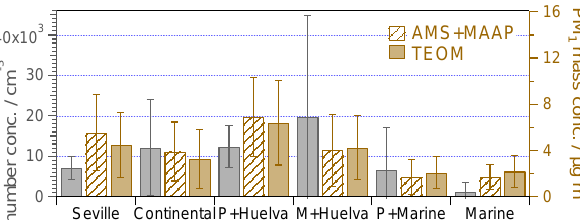
Fig. 6. Averaged particle number (grey) and mass (brown) concen- trations for the individual air mass categories. While hatched brown bars represent averaged submicron PM 1 mass concentrations deter- mined by adding HR-ToF-AMS species and black carbon concen- trations, brown filled bars show PM 1 mass concentrations measured using the TEOM. Standard deviations show the variability for the mentioned parameters within each air mass